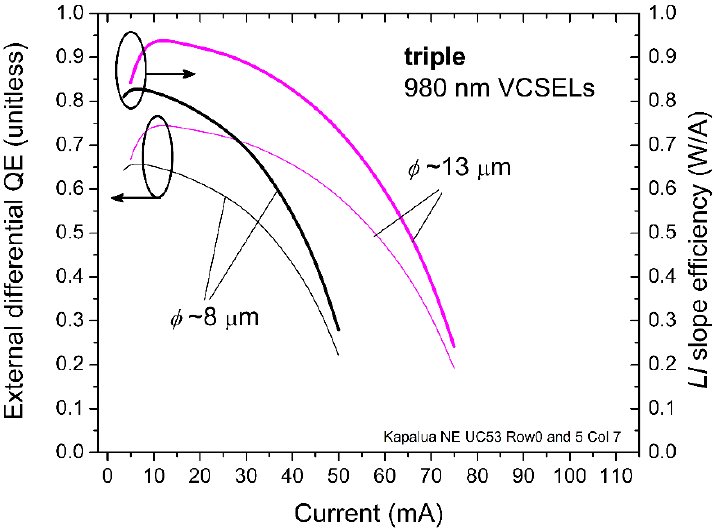
Figure 5. Extracted external differential quantum efficiency (QE) and LI slope efficiency versus DC bias current for the 980 nm triple VCSEL arrays in Figure 3 with ϕ ~8 and 13 μ m.